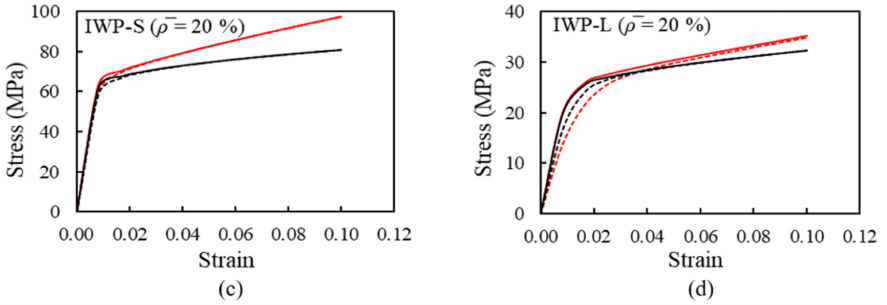
Figure 12. The stress–strain curve for tension/compression loading for ρ = 20% with and without